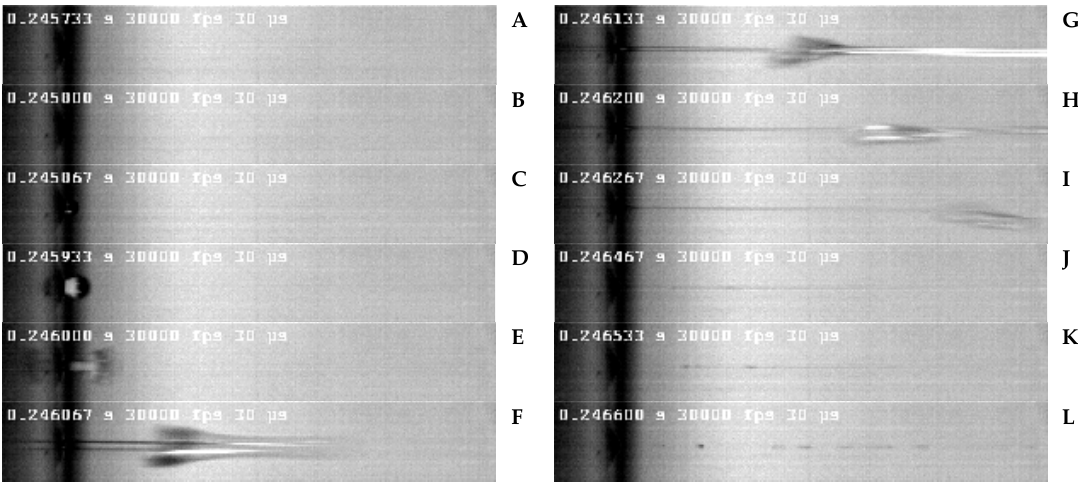
Figure 10. High-speed images of REPDTP drop formation with a time-interval of 67 µs between frames. Left from top to down: Frames 1 to 6. Right from top to down: Frames 7 to 12.